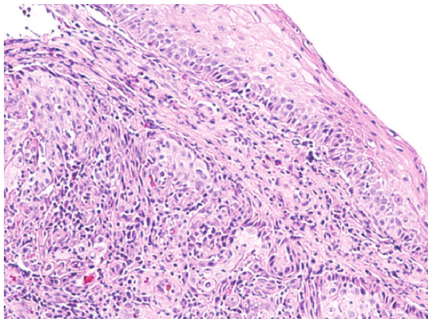
Figure 4: Biopsies of the esophageal mass showing poorly differen- tiated squamous cell carcinoma.